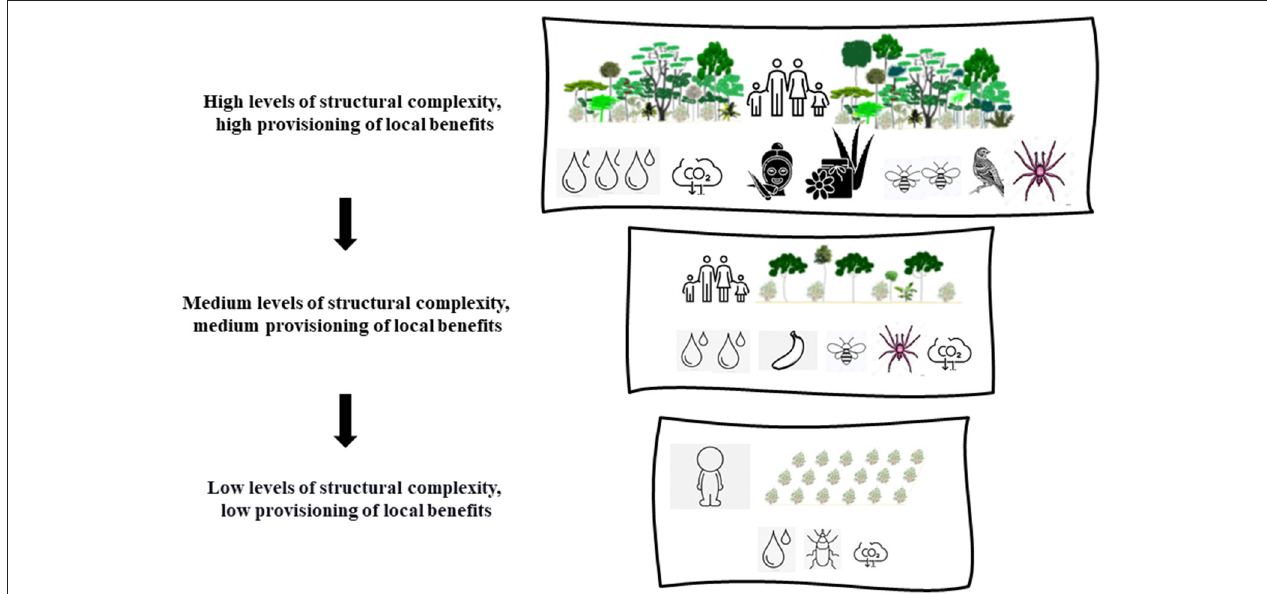
FIGURE 1 | The complex web of interaction between nature and farmers in traditional multi-layered AFS enables food provisioning, maintenance of physical, chemical, and biological properties of soil, water conservation, carbon stocks, and agrobiodiversity, compared to other systems that are simplified at the human and natural scale. Collaborative family labor plays a key role in fostering this